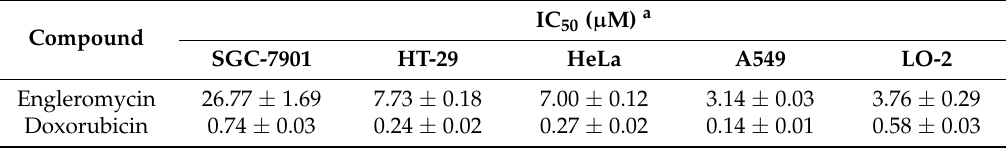
Table 1. Antiproliferative effects and cytotoxicity of engleromycin and doxorubicin.